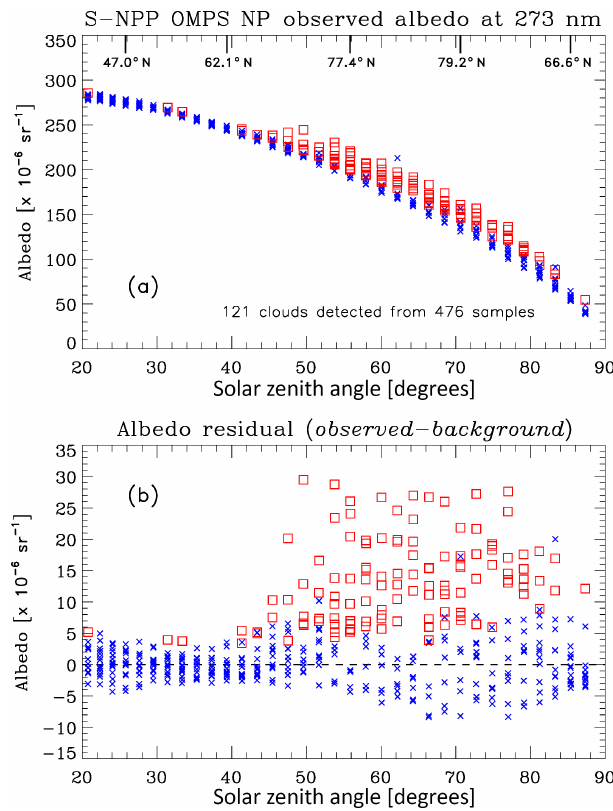
Figure 3. (a) S-NPP OMPS NP 273nm albedo values for all mea- surements in 2018 on day 189. Squares (red) indicate measurements identified as PMCs by the detection algorithm. Crosses (blue) in- dicate non-PMC samples. Tick marks (top x axis) show approxi- mate latitudes corresponding to selected solar zenith angle values. (b) 273nm albedo residuals (observed-background fit) for the mea- surements shown in panel (a) . PMC detections are indicated by